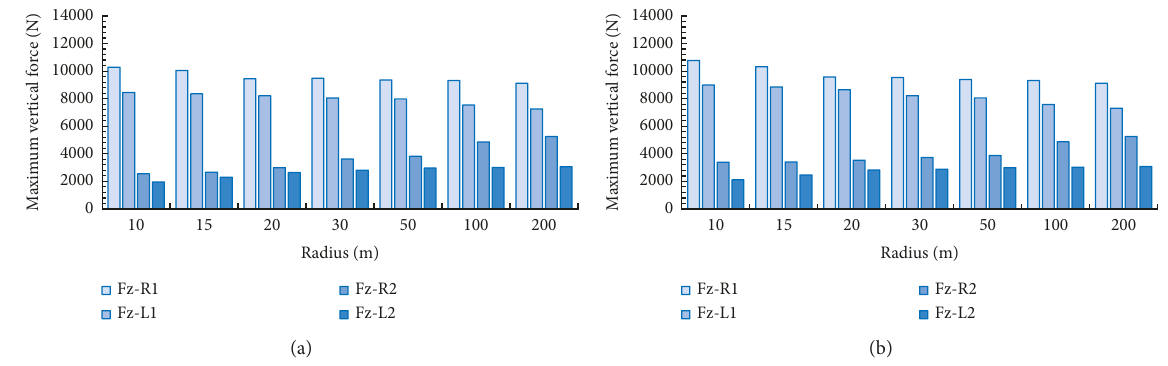
Figure 13: Maximum vertical force of the tire under different road conditions: (a) on dry road; (b) on wet road.